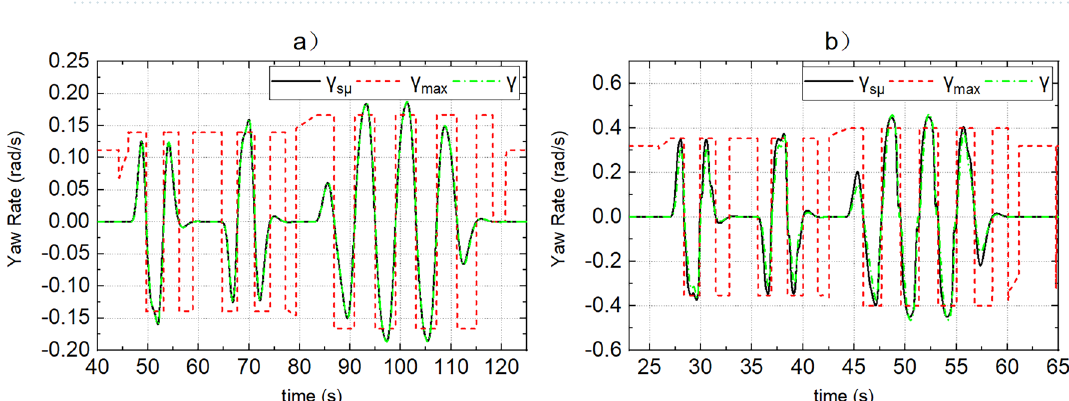
Figure 6. ( a , b ) Represent the response of yaw rate of dynamic boundary and actual yaw rate when the road adhesion coefficients are 0.15 and 0.8,